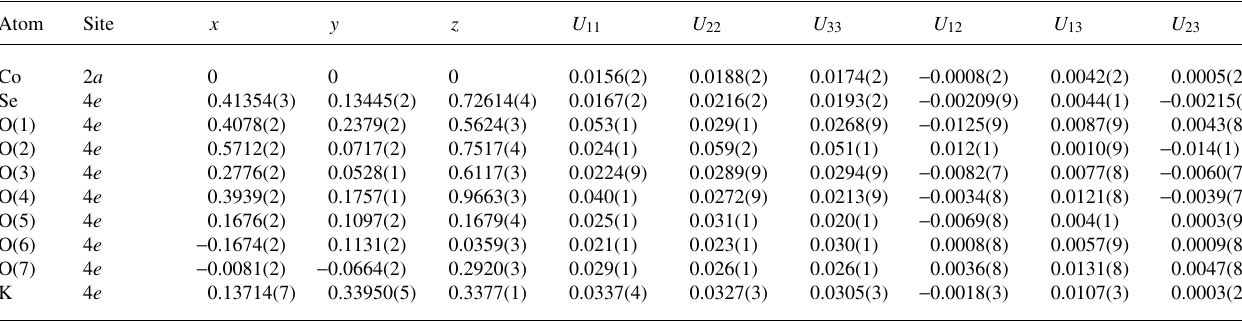
Table 6. Atomic coordinates and displacement parameters (in Å 2 ) .